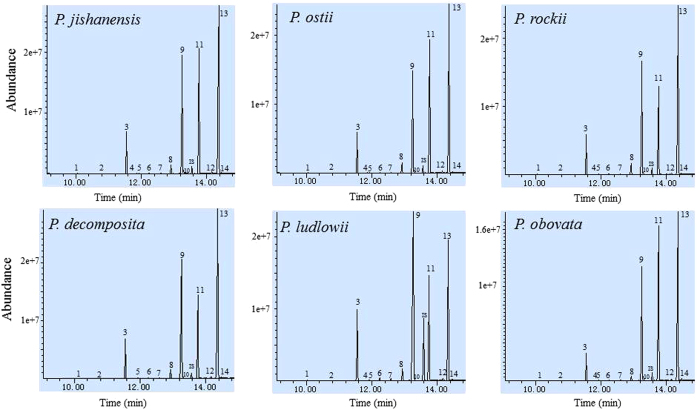
GC–MS of fatty acid methyl esters in the seeds of various Paeonia species.1: C14:0; 2: C15:0; 3: C16:0; 4: C16:1Δ7; 5: C16:1Δ9; 6: C17:0; 7: C17:1Δ10; 8, C18:0; 9: C18:1Δ9; 10: C18:1Δ11; 11: C18:2Δ9,12; 12: C20:0; 13: 18:3Δ9,12,15; 14: C20:1Δ11; IS: internal standard, nonadecanoic acid.